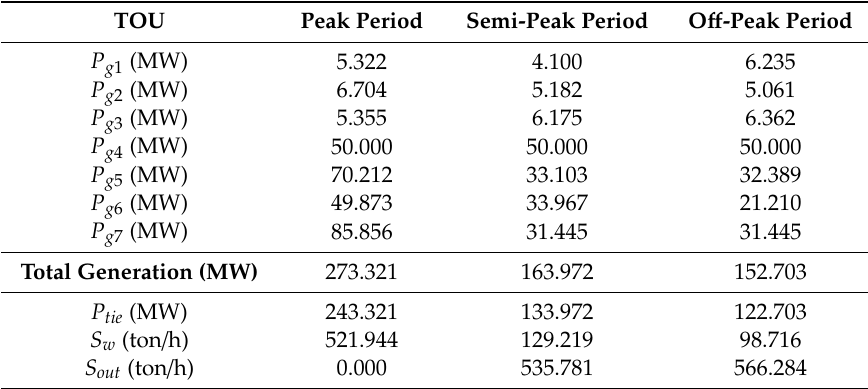
Table 6. Dispatch results at di ff erent TOU intervals.